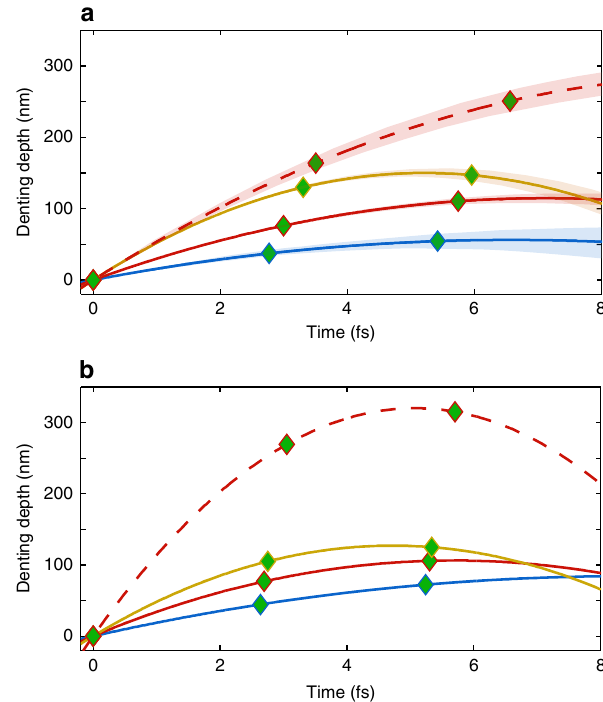
Fig. 5 Waveform-dependent relativistic plasma surface denting. a Parabolic interpolation for the plasma surface motion evaluated from the measured XUV spectra. Red, blue, and yellow solid lines correspond to the plasma Fig. 4 Spectral interferometry of three APs. a Measured XUV spectrum scale length L / λ L ≈ 0.13 and respective ϕ CEP values 7 π /6, π /2, and 5 π /3 — with ϕ CEP ≈ π and L / λ L ≈ 0.5 within selected spectral range. b center and the edges of the CEP range leading to a P3 peak in FT above the Corresponding FT using the 33 – 57 eV range. Peaks P1, P2, and P3 represent noise level. Red dashed line shows plasma surface denting for signi fi cantly interference of different pairs of three involved APs: AP2 & AP3, AP1 & softer plasma L / λ L ≈ 0.5 and ϕ CEP ≈ 7 π /6. Lines are fi ts based on the mean AP2, and AP1 & AP3, respectively. Dashed lines show the applied temporal value of the generation points (with in ϕ CEP ± Δ ϕ RMS ), shaded areas gate functions for inverse FT. c Reconstructed individual spectra of all three correspond to standard deviation. b Similar reconstruction based on the APs within the considered spectral range. d Corresponding spectral phase simulated spectra. CEP values are the same as above and scale lengths are L / λ = 0.13 for solid lines and L / λ = 0.4 for dashed line. For all the cases, differences without the linear term. Black dashed line illustrates the sum L L ϕ + ϕ ϕ − π /2 constant is added to ϕ fi rst AP spatial and temporal coordinates are used as reference P1 P2 , which well matches P3 . A P3 and the phase sum line for better visibility. e Reconstructed plasma surface dynamics, based on the calculated relative coordinates of three APs (see Methods). f Result of 1D LPIC simulation for the electron density in the plasma driven by the laser fi eld with pulse parameters similar to the experiment ( ϕ CEP = π and L / λ L = 0.4). The green diamonds mark the points where XUV pulses are generated and are obtained from the interferometric evaluation of the simulated spectrum. The color bar indicates normalized electron density n / n c . The blue line is a parabolic interpolation based on these three generation points that coincides well with the averaged plasma surface denting. Green lines show propagation directions of the generated XUV